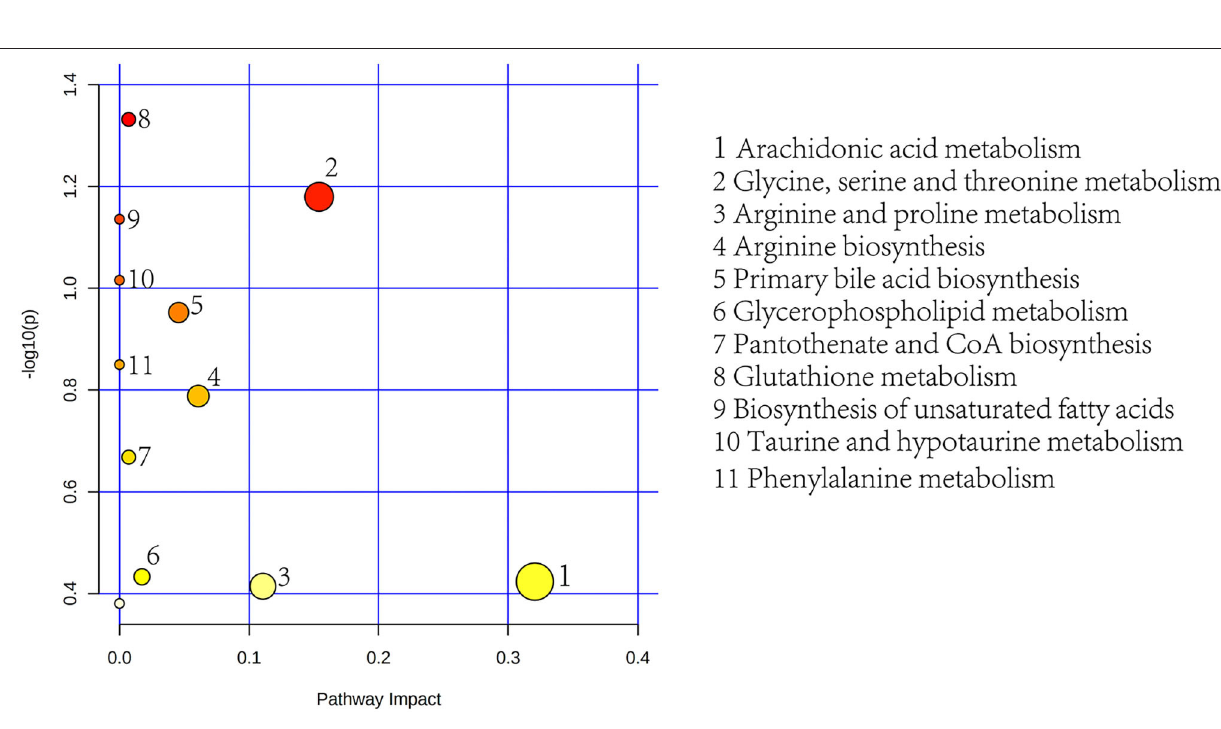
FIGURE 8 | Plasma metabolic pathway analysis using MetaboAnalyst 5.0 (http://www.metaboanalyst.ca; x -axis, pathway impact; y -axis, –log p ). Circles represent metabolic pathways. Darker circles indicate more significant changes in the metabolites in the corresponding pathway, whereas the size of the circle corresponds to the pathway impact